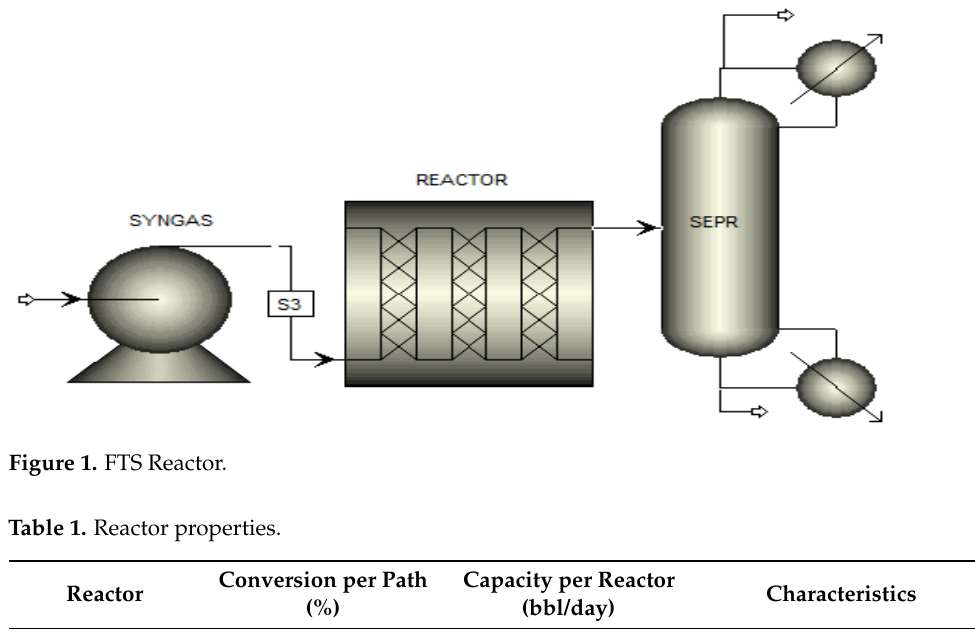
Table 1. Reactor properties.